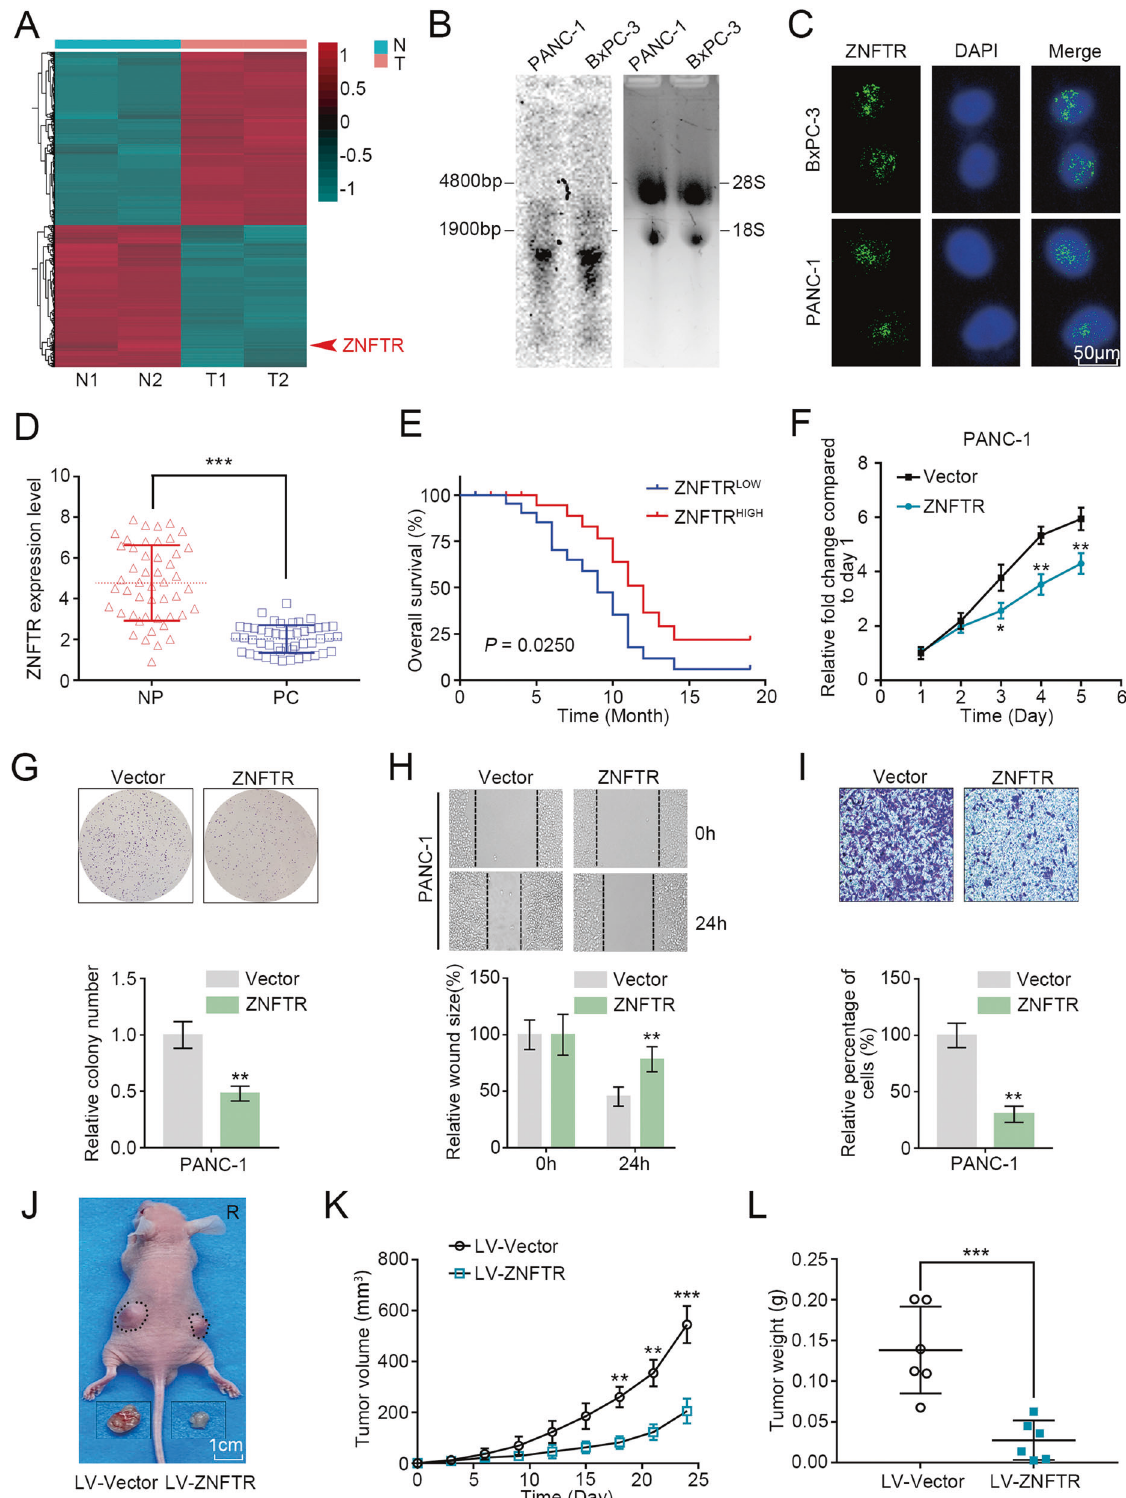
The expression level of ZNFTR in four PC cell lines was conspicuously lower than that in the human pancreatic duct epithelial cell line (Fig. S2B). Meanwhile, the qRT-PCR assay showed that the transcript level of ZNFTR in PC tissues was lower than that in NP tissues (Fig. 1D). The basic information of